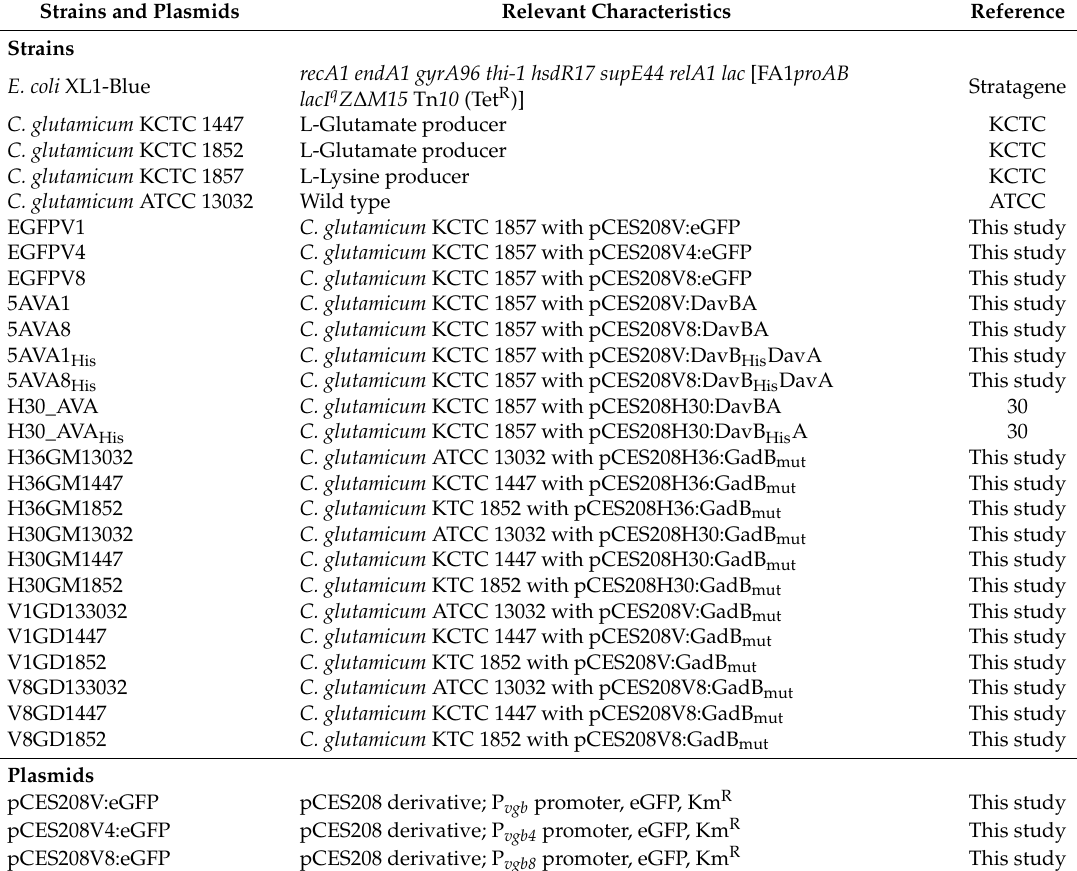
Table 1. Strains and plasmids used in the present